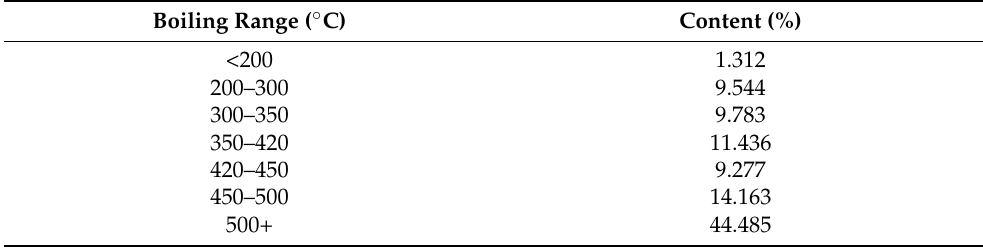
Table 1. Mass distribution of pseudo-components in different boiling ranges of the